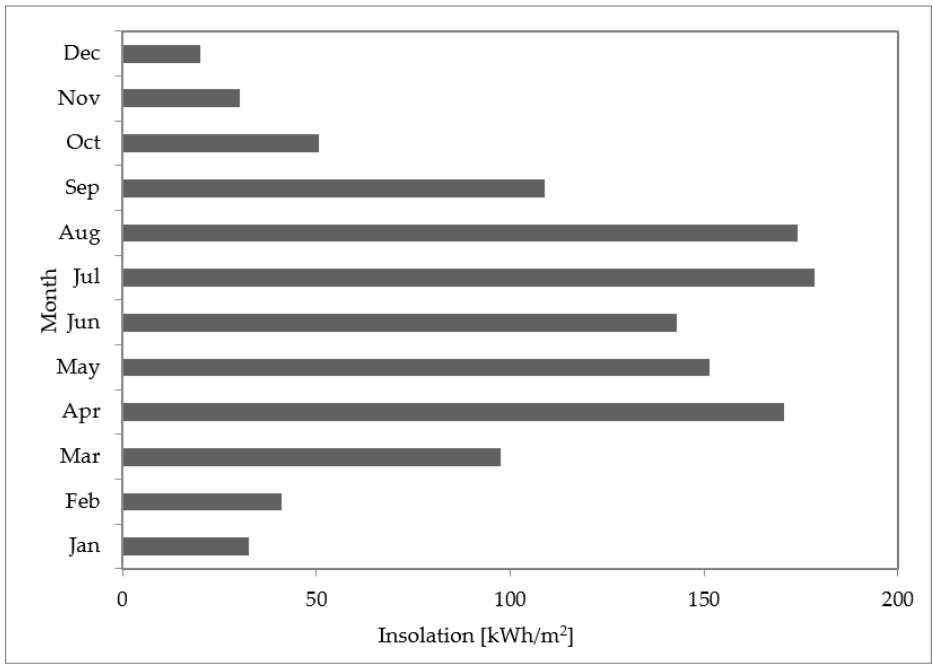
Figure 11. Insolation in individual months of 2020 based on measurements from the SolarAOT station.